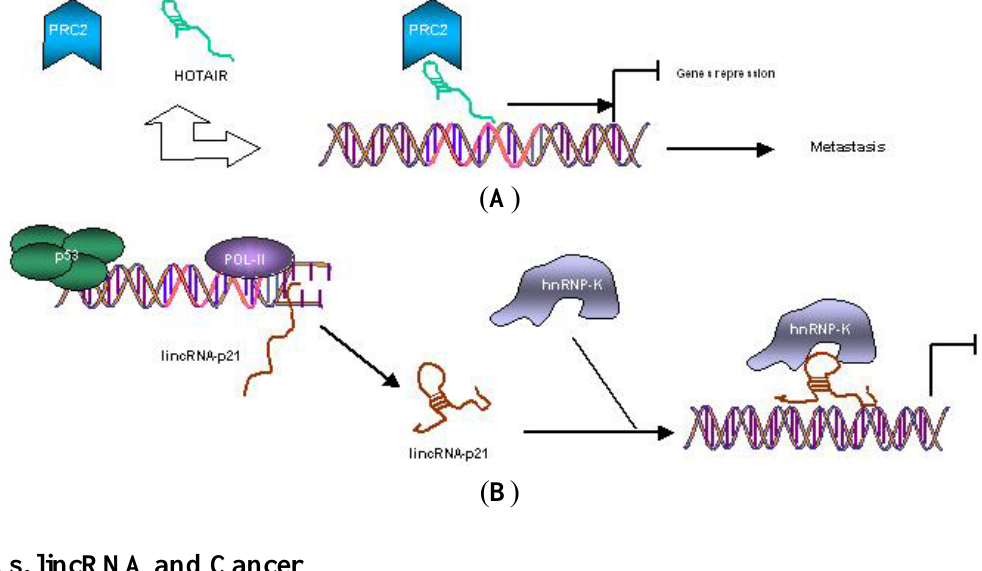
Figure 1. ( A ) Mechanisms of gene regulation by oncogenic lincRNA HOTAIR. HOTAIR recruits PRC2 to specific gene promoters, inducing gene repression that leads to tumor metastasis; ( B ) Mechanisms of gene regulation by tumor-suppressor lincRNA-p21, where its expression is directly induced by p53. Then, lincRNA-p21 specifically interacts with hnRNP-K for localization to gene promoters for repression